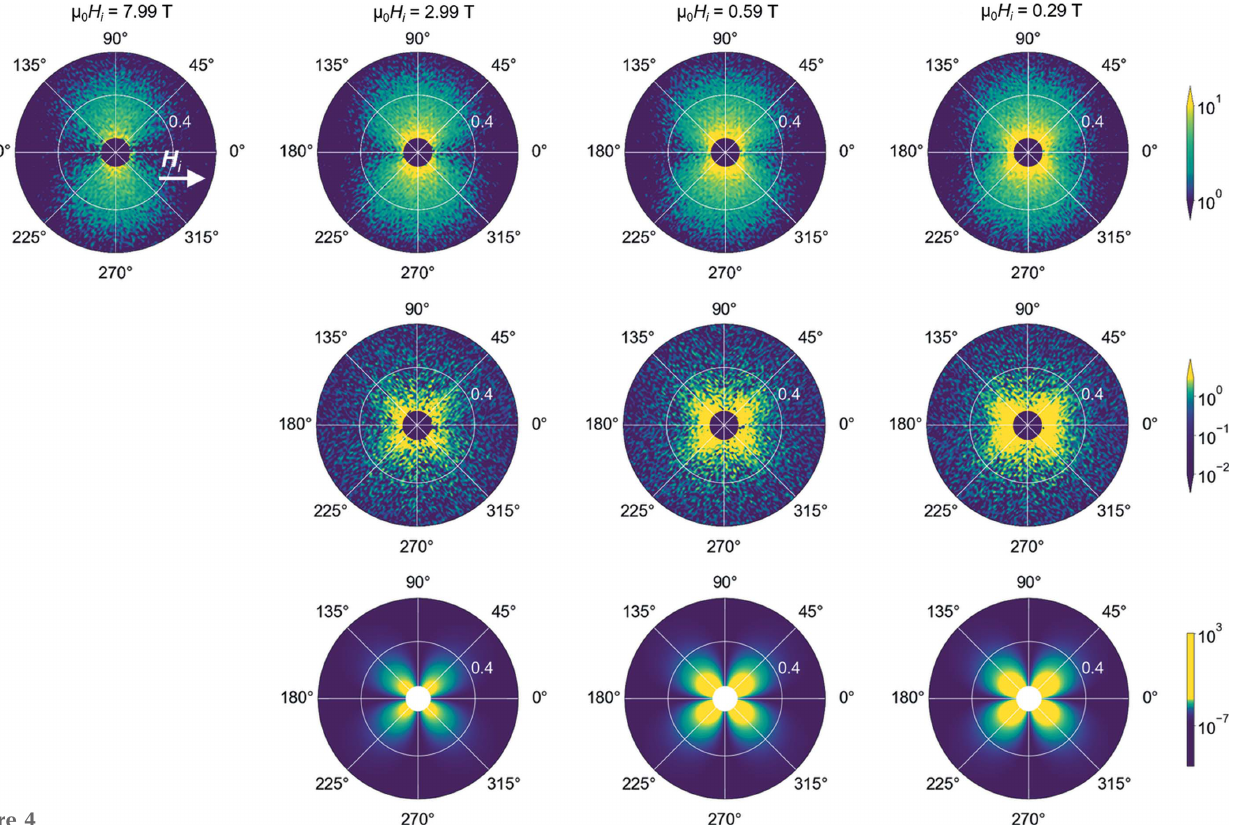
Figure 4 Experimental 2D total (nuclear + magnetic) SANS cross section d (cid:3) /d (cid:4) of (Fe 0.7 Ni 0.3 ) 86 B 14 alloy at the selected fields 7.99, 2.99, 0.59, 0.29 T (upper row), and the corresponding purely magnetic SANS cross section d (cid:3) mag /d (cid:4) (middle row). Experimental d (cid:3) mag /d (cid:4) were obtained by subtracting d (cid:3) /d (cid:4) at the (near-) saturation field of 7.99 T from the data at the lower fields. The applied (internal) magnetic field H i is horizontal in the plane of the detector ð H ? k Þ . Lower row: computed d (cid:3) mag /d (cid:4) based on the micromagnetic SANS theory [Equations (5)–(9)] at the same selected field values as above, and i 0 using the experimental parameters given in Table 1. Note that d (cid:3) /d (cid:4) and d (cid:3) mag /d (cid:4) are plotted in polar coordinates with q (nm (cid:3) 1 ), (cid:5) ( (cid:11) ) and intensity (cm (cid:3) 1